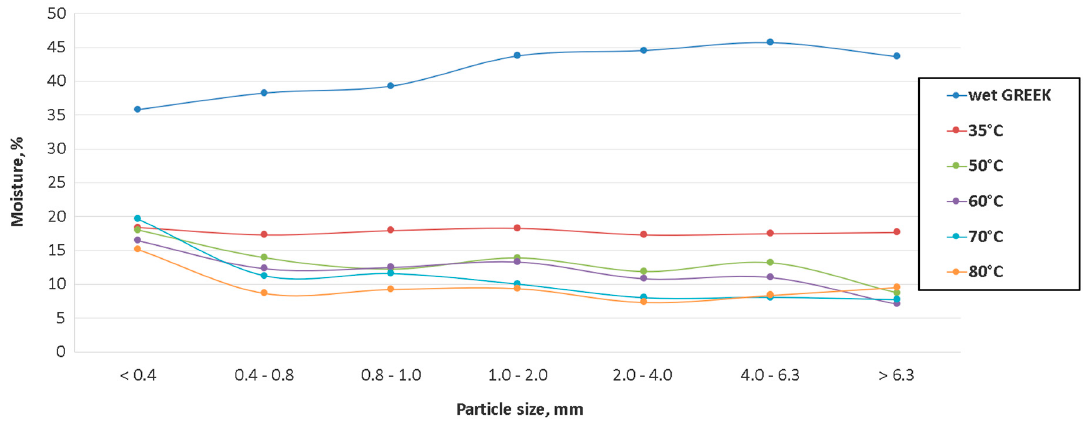
Figure 6. Difference between the moisture content of particles of different sizes for wet and dried lignite—an example of Greek lignite for various temperatures of the drying process.